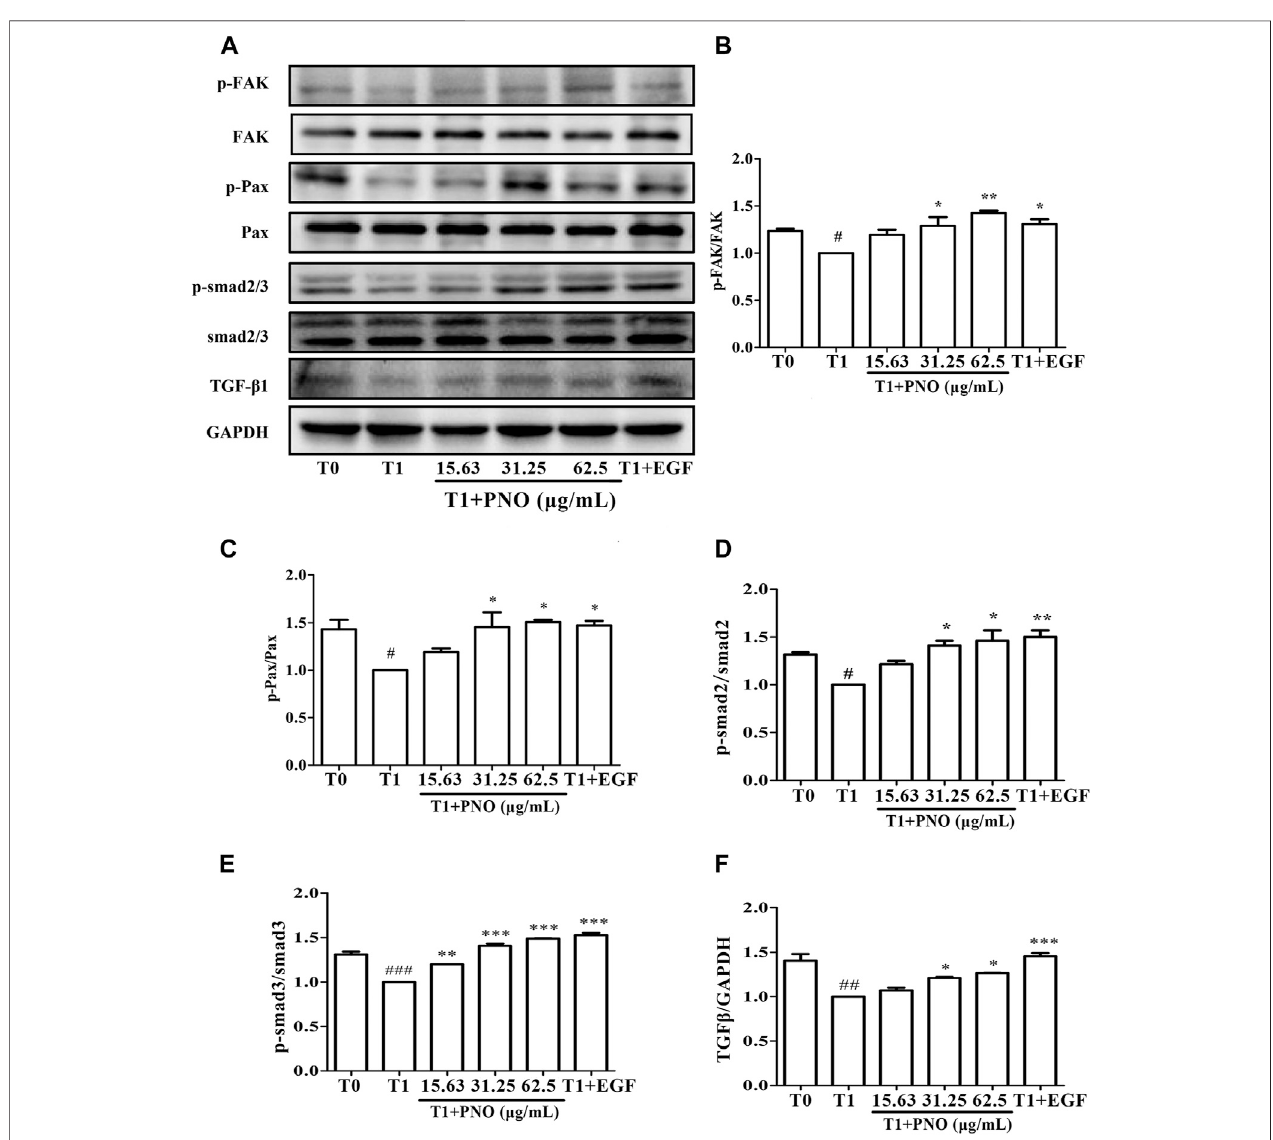
FIGURE7 | EffectofPNO on expression ofmigration regulatoryproteinsand TGF- β 1/Smad signaling pathway in replicativesenescentNIH-3T3 cells. (A) Western blotting analysis of expression of migration regulatory proteins and TGF- β 1/Smad signaling pathway. (B – F) Quanti fi cation of bands relative to GAPDH using Image J software.Alldataarepresented asthemean ± SDofat leastthreeindependentexperiments. # indicatesasigni fi cantdifferentrelative toT0group. # p < 0.05, ## p < 0.01, ### p < 0.001. * Indicates a signi fi cant different relative to T1 group. * p < 0.05, ** p < 0.01, *** p < 0.001.